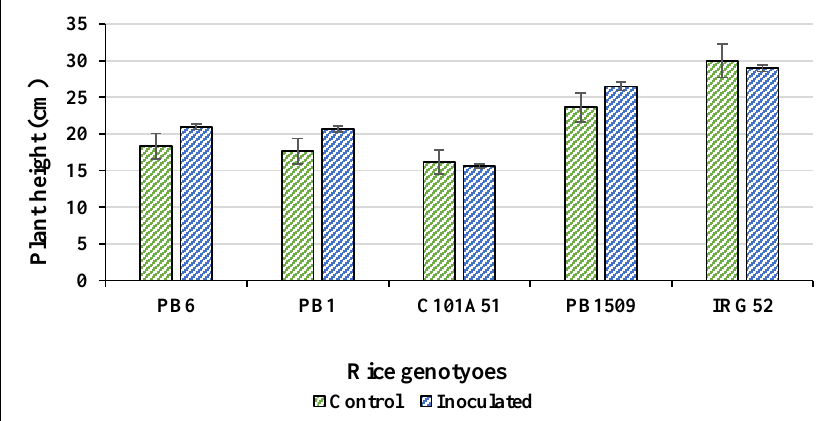
Figure 4. Elongation of the rice genotypes due to infection by Fusarium fujikuroi . Significant elon- gation in plant height was observed in Basmati rice varieties (PB6, PB1, and PB1509) as compared non-Basmati genotypes (C101A51 and IRG52 — no significant elongation/stunting was observed). Mean plant heights of all treatments (all combinations) were taken to plot the graph (in each repli- cation, 3 plants were recorded). Error bars represent standard error.